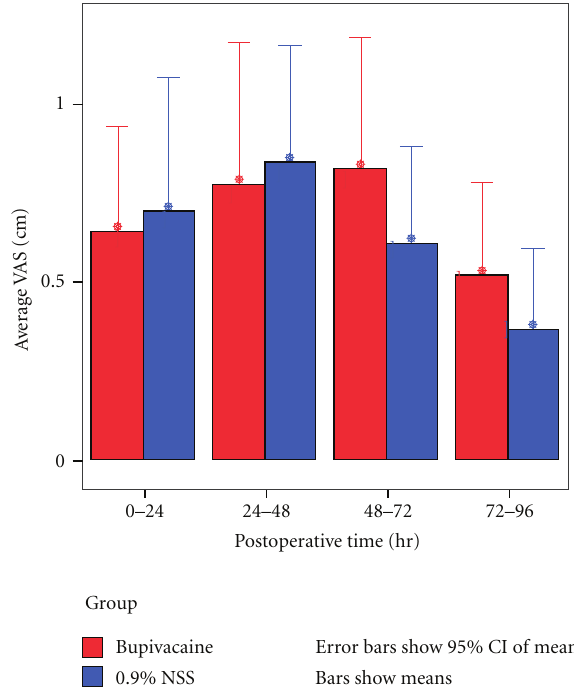
Figure 2: Post-operative morphine consumption at 96 hours after operation ∗ P < 0 . 05. Figure 3: Postoperative mean visual analog scale score at 96 hours after